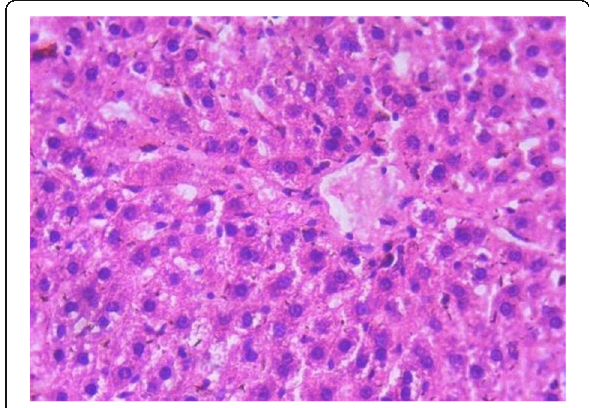
Fig. 1 Photomicrograph of the liver section of the control rats showing no abnormality (× 40)